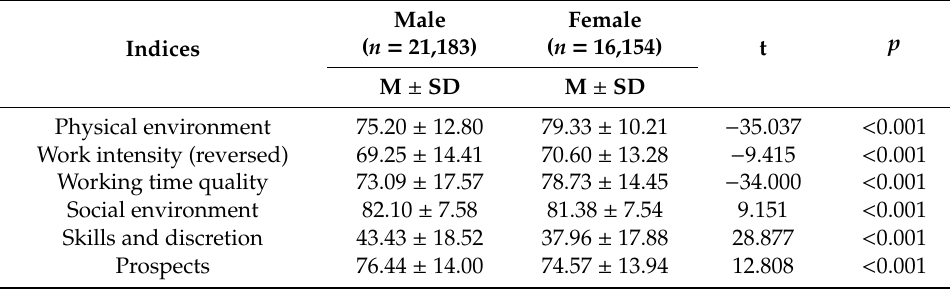
Table 2. Comparison of job quality indices by